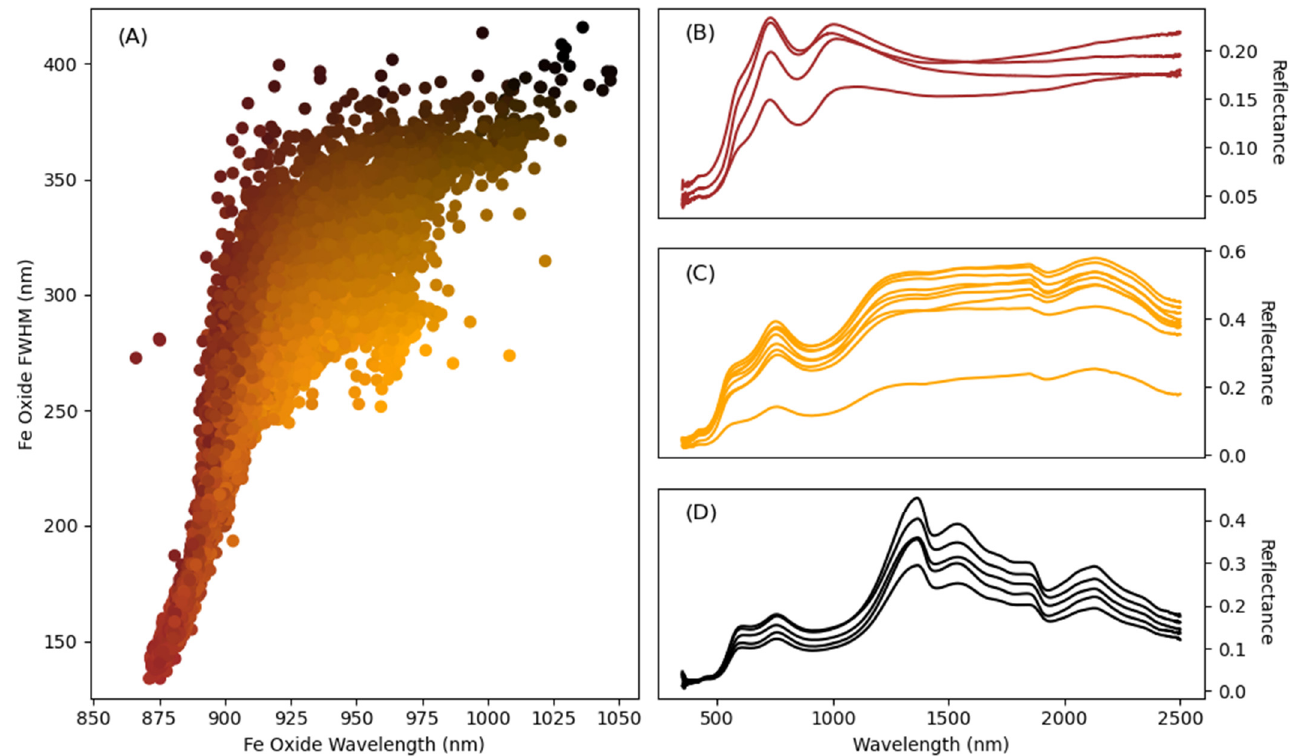
Figure 12. ( A ) The false colour iron boomerang for drillcore 1 coloured in the same manner as the downhole plots, ( B ) in-situ selected hematite endmembers, ( C ) in-situ selected ochreous goethite endmembers, and ( D ) library selected vitreous goethite endmembers.